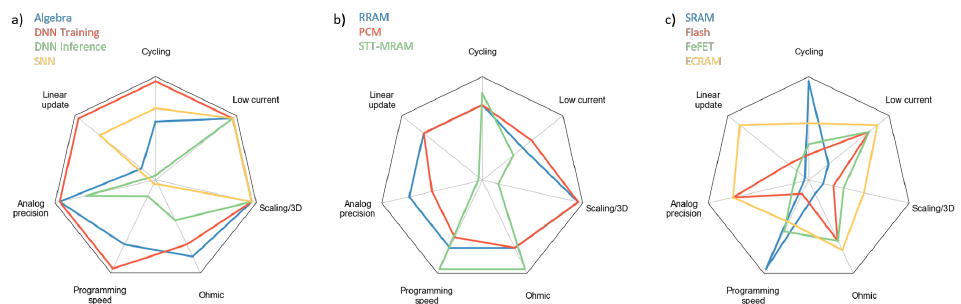
Figure 14. Application requirements ( a ) and figures of merit for various memory technologies with 2-terminal ( b ) and -terminal structure ( c